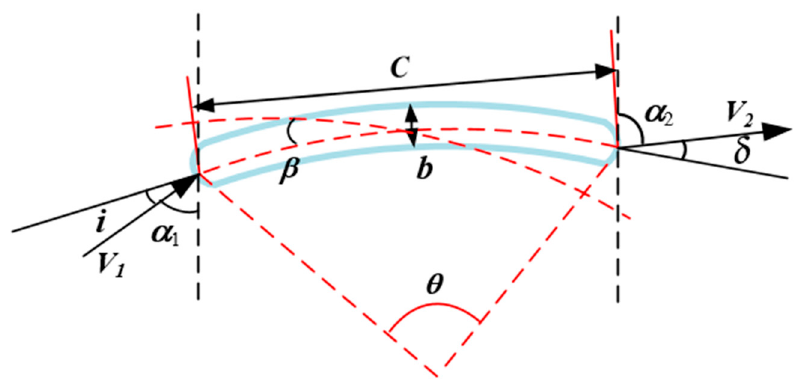
Figure 7. A schematic diagram of guide vane geometric parameters.